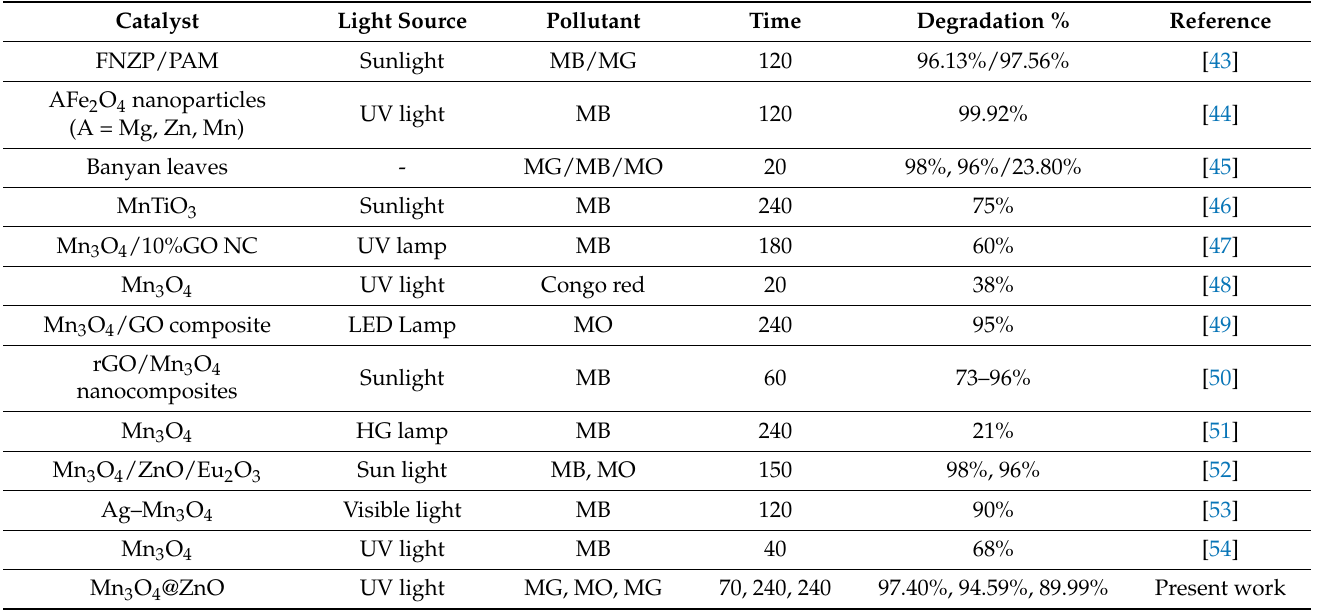
Table 2. Comparison table of previously reported photocatalysts and their degradation